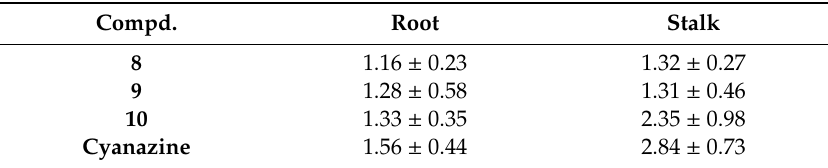
Table 4. The EC 50 values (mmol / L) of compounds 8–10 against the root of E. crus-galli. Compd.